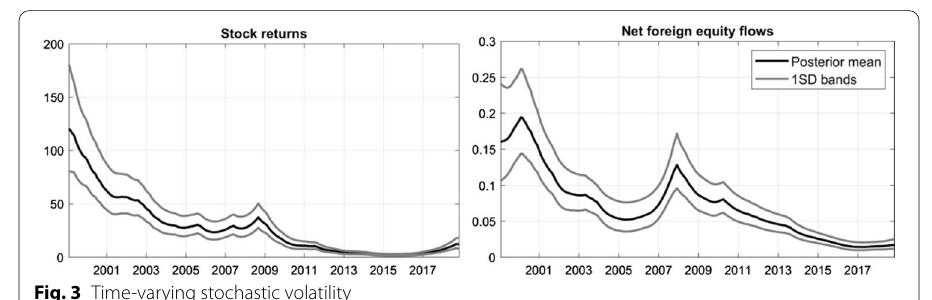
Fig. 3 Time-varying stochastic